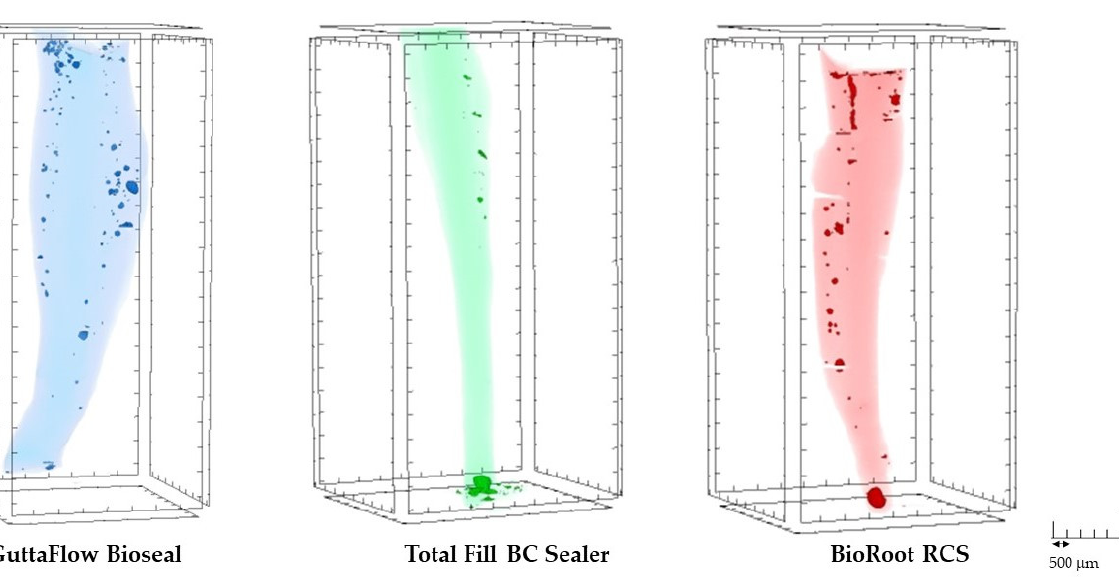
Figure 5. Regional and total porosity (%) of sealers in the root canal after 7 days ( A ) and 6 months ( B ). A—same superscript letters indicate statistically significant differences ( p < 0.05). After a 7-day incubation, significantly higher regional porosity was found in the ap- ical part compared to the coronal area for BioRoot RCS ( p < 0.05). In the apical region, a significantly higher porosity was found for BioRoot RCS compared to GuttaFlow Bioseal ( p < 0.05). After 6 months, no statistically significant differences in regional porosity be- tween the root regions were detected (Figure 5). The highest (both initial and long-term) apical porosity was observed for BioRoot RCS (2.24% ± 1.67% and 2.99% ± 2.46%, respectively). The smallest apical porosity after 7